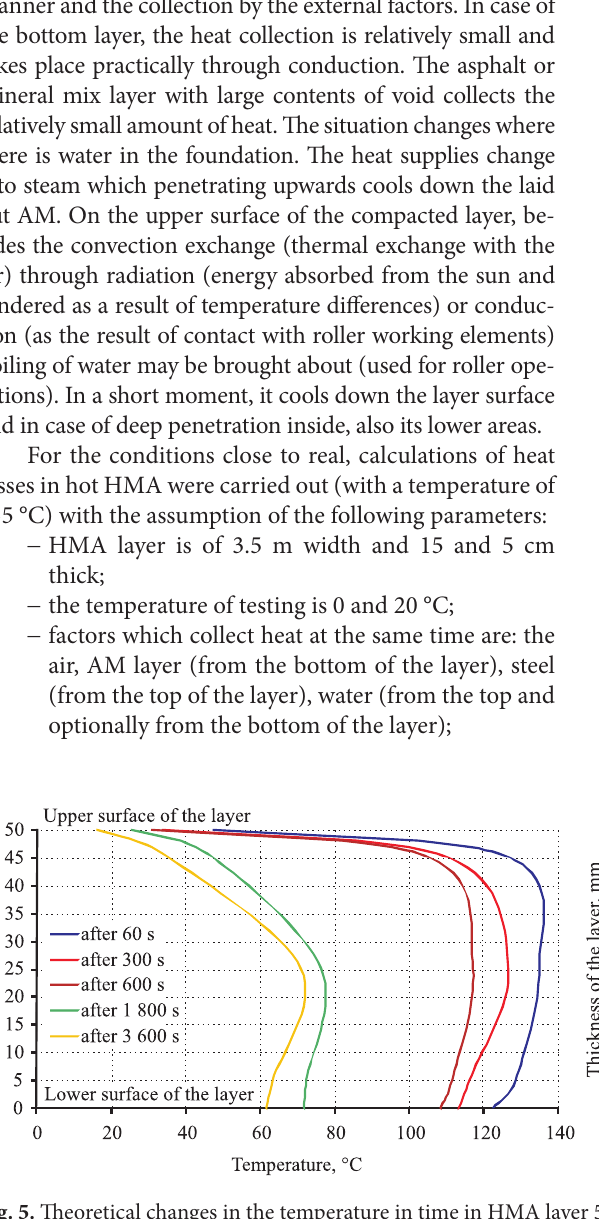
Fig. 5. Theoretical changes in the temperature in time in HMA layer 5 cm thick in the air temperature: a – 0 °C and with the wind of 0 m/s velocity (with water not staying in the foundation); b – 20 °C with the wind of 8 m/s (with water staying in